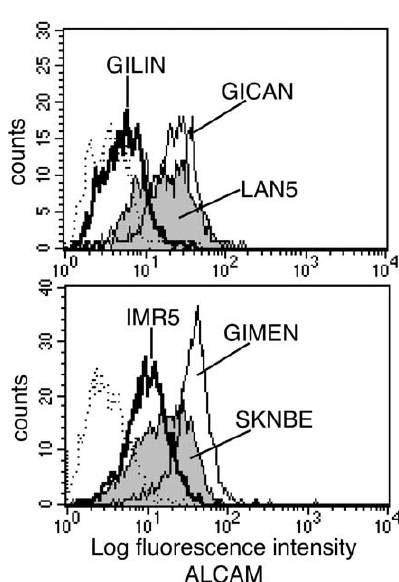
Fig. 1. Cell surface expression of the ALCAM molecule by human neuroblastoma cell lines. Immunofluorescence analysis of ALCAM surface expression by anti-ALCAM scFv I/F8 staining and flow cy- tometry. Dotted lines represent background fluorescence obtained with an irrelevant scFv.